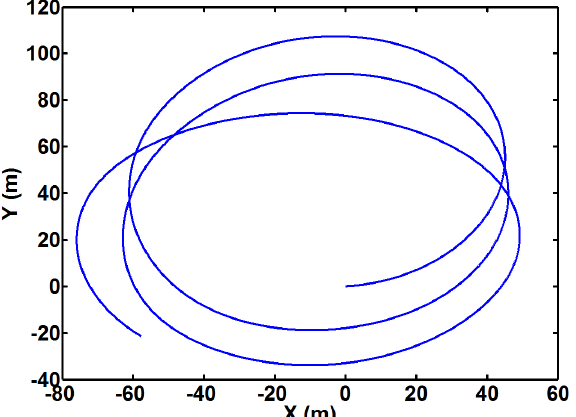
Figure 7. The simulation of turning test with